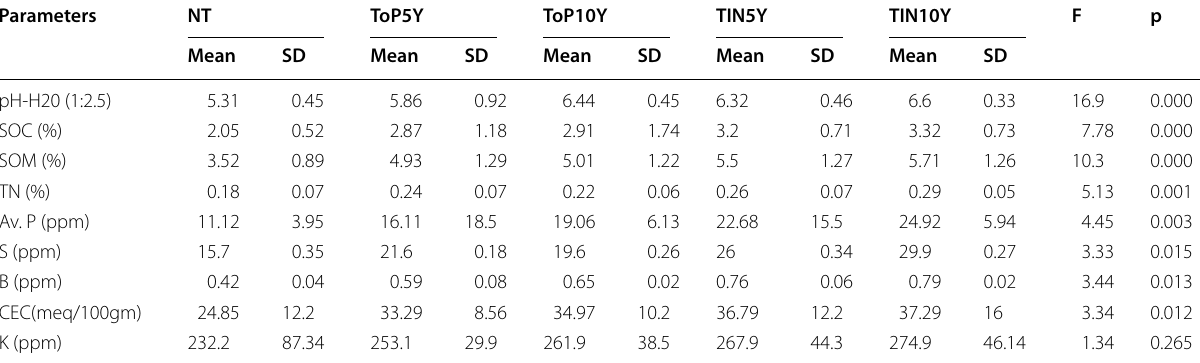
NT non-treated land, TolP5Y treated with only physical practices for 5 years, TolP10Y treated with only physical practices for 10 years, TIN10Y treated with integrate measures for 5 years, TIN10Y treated with integrate measures for 10 years, ppm parts per million Table 4 One way ANOVA test results for selected soil quality indicators